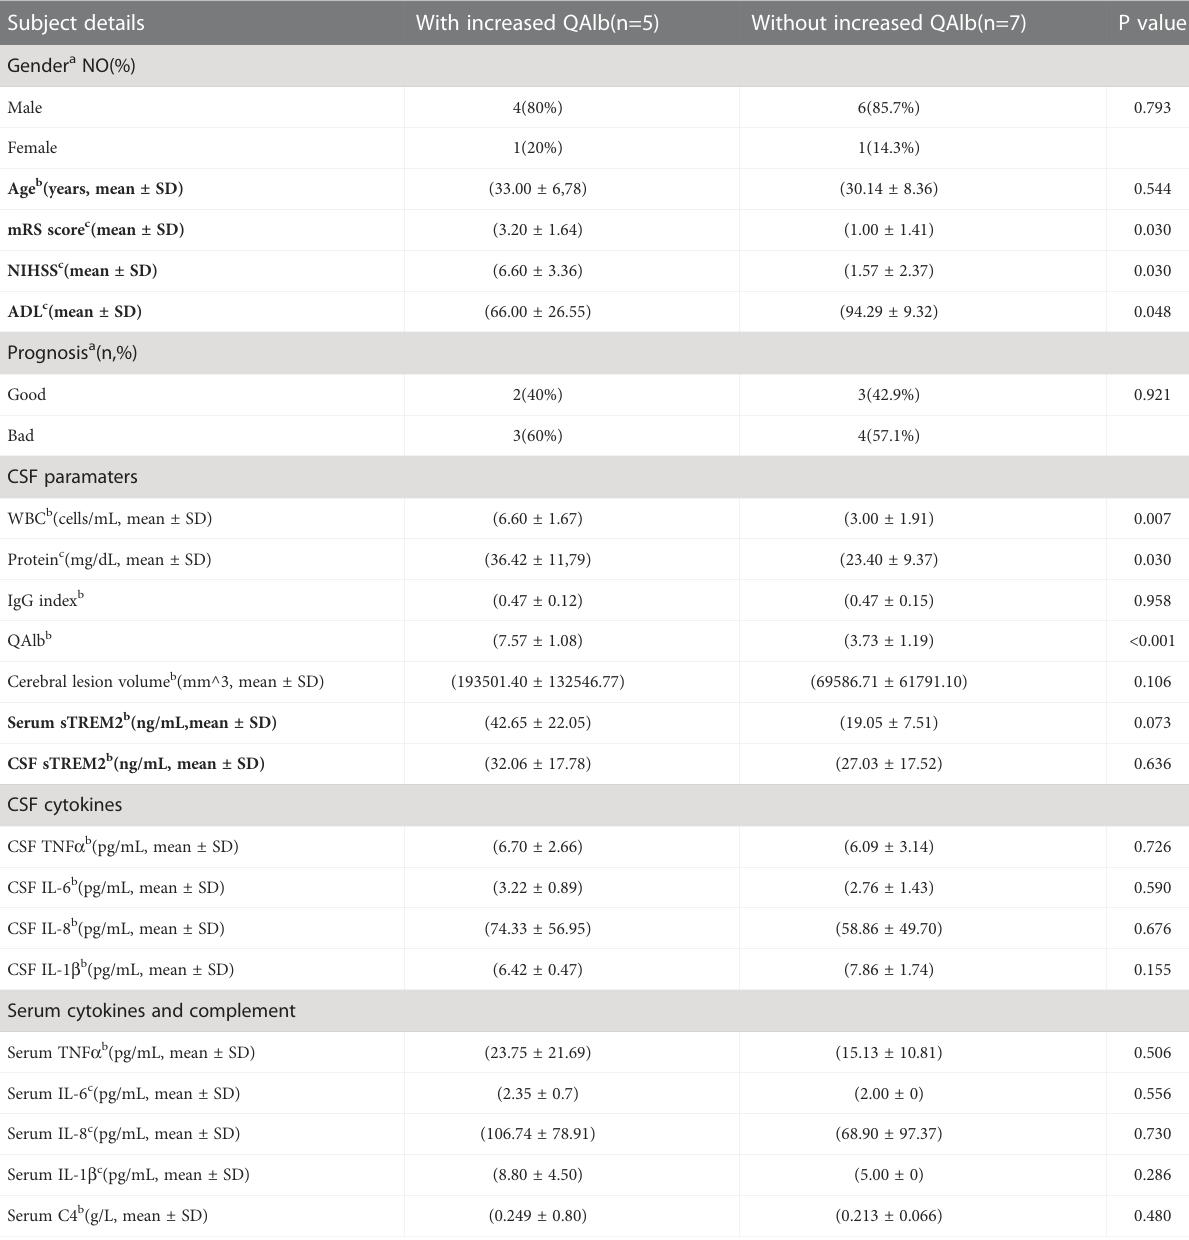
TABLE 3 Difference about clinical and Laboratorial data between PACNS patients with and without increased